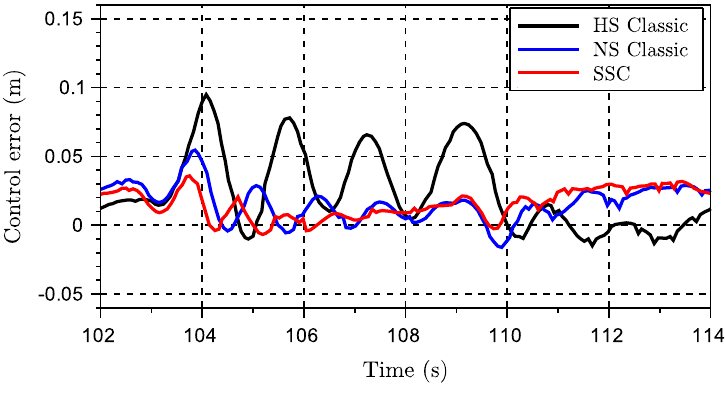
Figure 16. Pressure levels on the A-side of the active system for scenario 1.